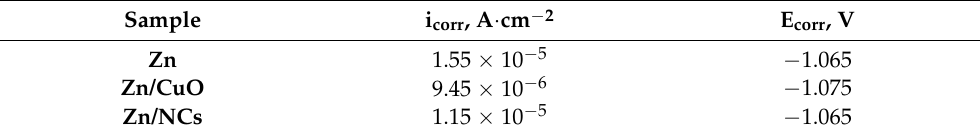
Table 2. Electrochemical parameters obtained from the potentiodynamic polarization measure- ments.